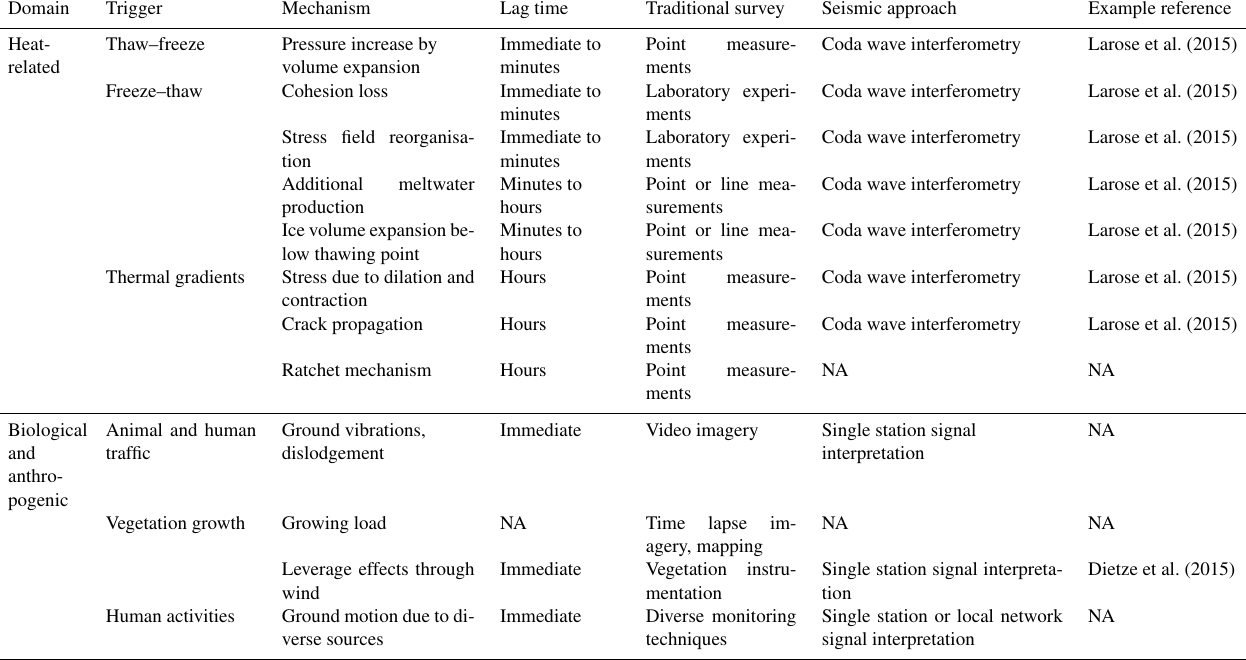
Table 2. Summary of rockfall triggers and potential approaches to survey and monitor them. Seismic approaches and their references were chosen based on existing links of trigger investigations and mass-wasting